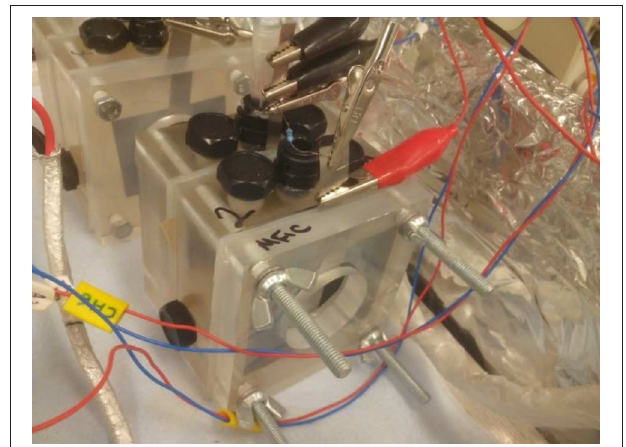
FIGURE 1 | MFC with GDE design operated for this